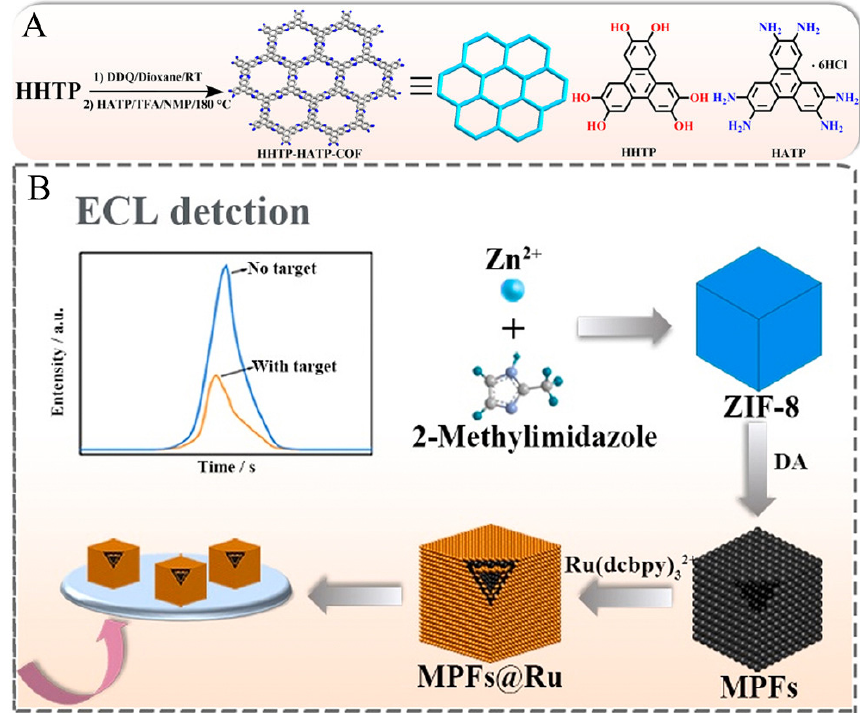
Figure 6. ( A ) Synthesis of HHTP-HATP-COF [88]. Copyright © 2022 American Chemical Society. ( B ) Preparation of MPFs@Ru [25]. Copyright © 2021